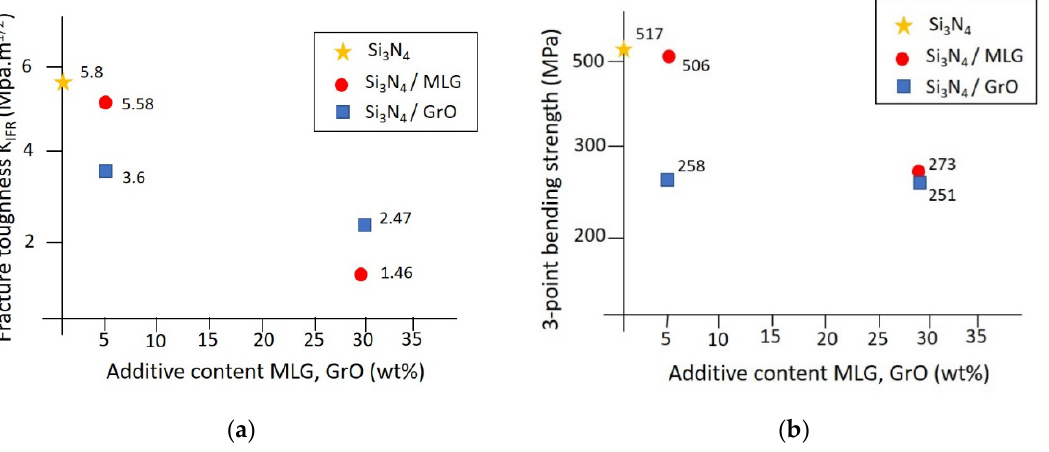
Figure 4. Fracture behavior of Si 3 N 4 -based composites. ( a ) fracture toughness, ( b ) 3-point bending strength. K IFR = 0.0334(E/H) 0.4 (P/l 1.5 ), where H is the Vickers hardness, E is the modulus of elasticity, P is the applied force and l is the length of cracks.